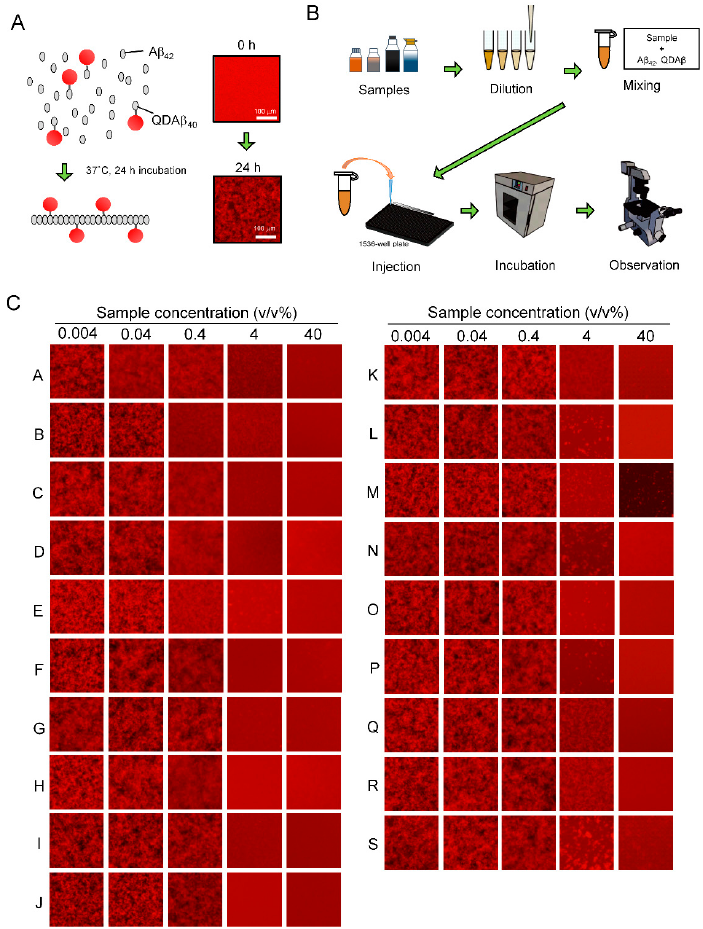
Figure 3. Evaluation of A β 42 aggregation inhibitory activity using the MSHTS system. ( A ) Real-time imaging of A β 42 aggregation using a quantum-dot nanoprobe using fluorescence microscopy. A β 42 and QDA β were mixed and incubated for 24 h at 37 °C. Co-aggregates of A β 42 and QDA β formed. ( B ) A scheme of the MSHTS system of A β 42 aggregation inhibitors. ( C ) Fluorescence microscope image of concentration-dependent inhibition of A β 42 aggregation of dressings observed by the MSHTS system. At a sample concentration of 4 v / v % or more, the brightness of the image was uniform, indicating that no A β 42 aggregates formed. At a sample concentration of 0.04 v / v % or less, A β 42 aggregates were observed in all samples. All images were captured using a conventional fluorescence microscope.